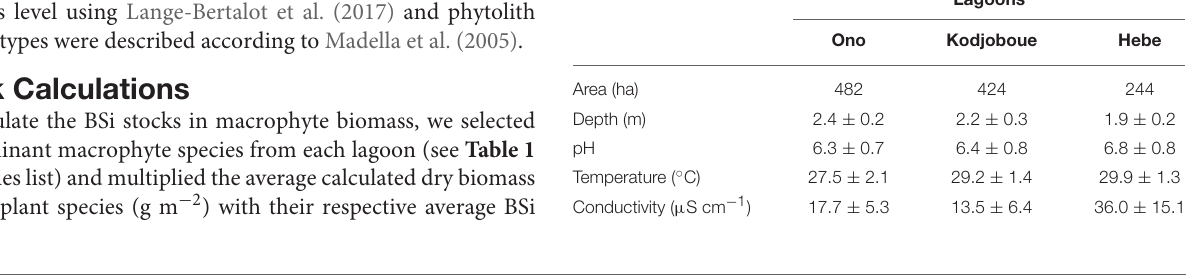
TABLE 1 | Characteristics and occurrence of macrophyte species collected in the three lagoons ( × , presence of the species; #, species used for phytolith visualization; *, species’ values used in BSi stock calculation). Species